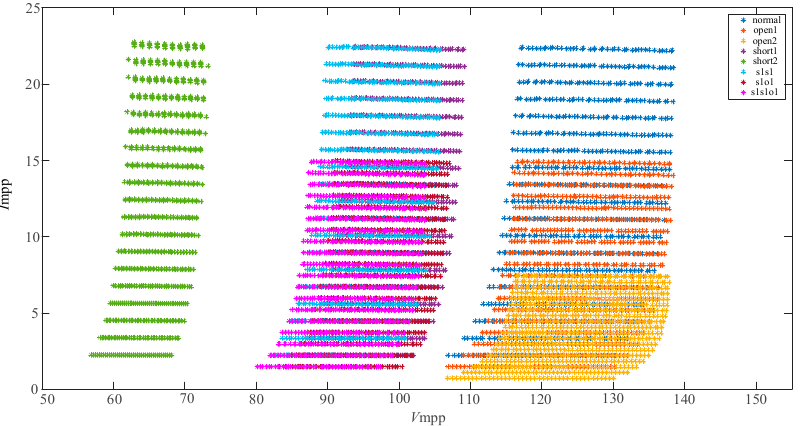
(cid:0) (cid:1) V mpp , I mpp , V I . mpp mpp